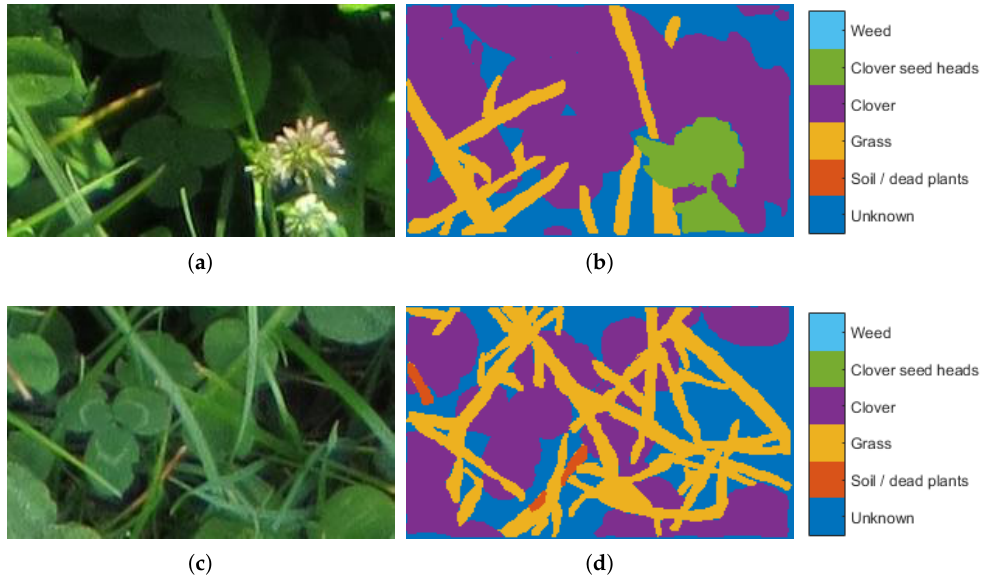
Figure 2. Patches extracted from the image captured in direct ( a ) and indirect ( c ) sunlight and the corresponding annotated image patches ( b ) and ( d ),